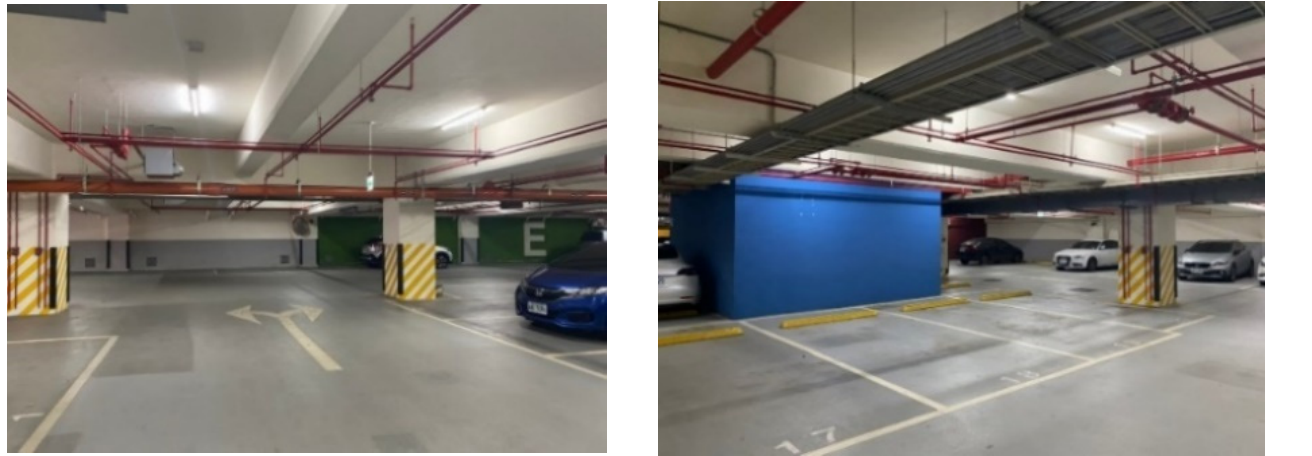
Figure 2. Calibration